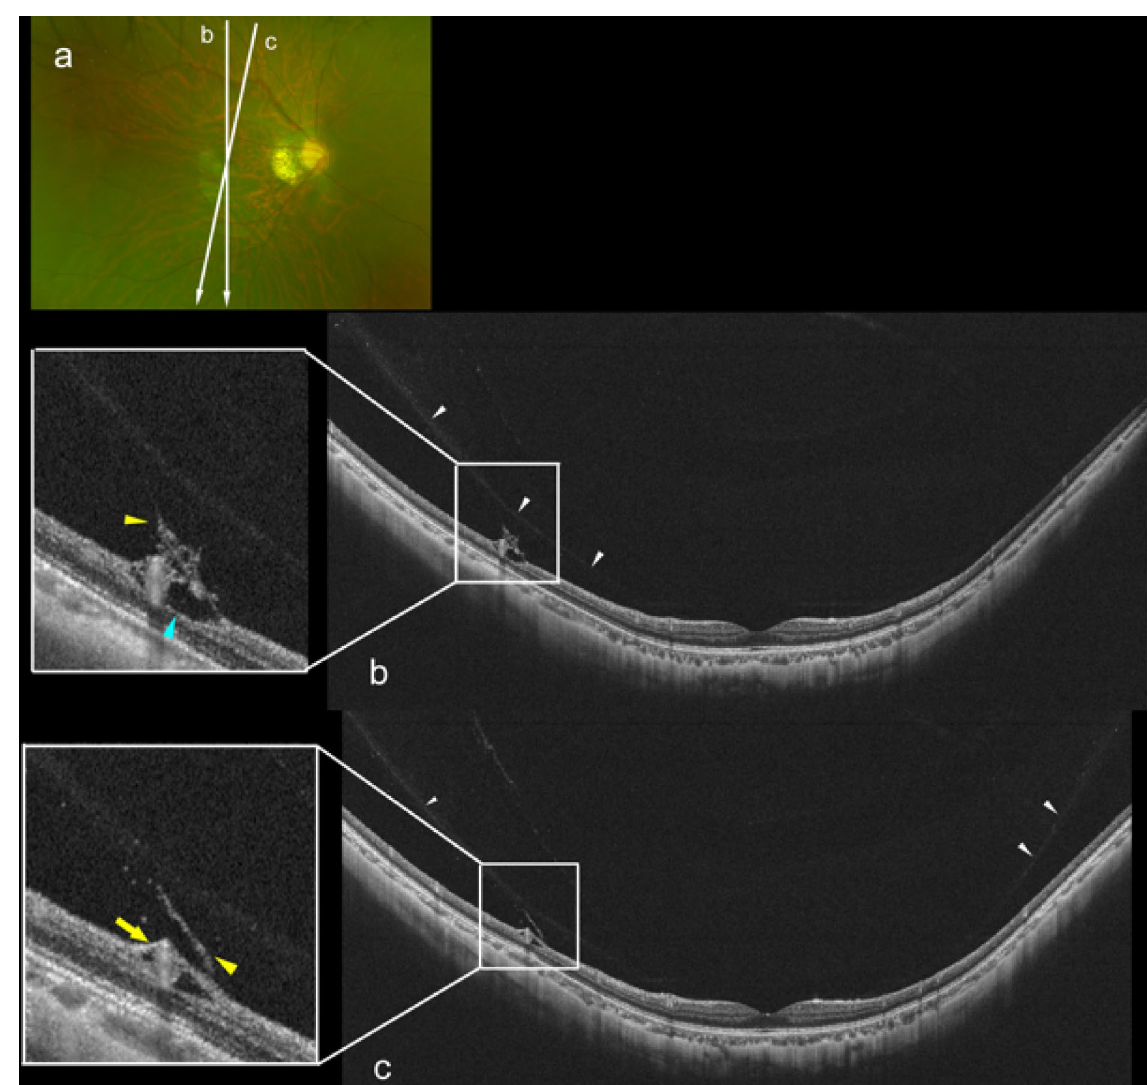
Vertical UWF OCT image showing a paramacular PVD at the area superior to the macula (white arrowhead). Medium reflective bridging tissue can be seen connecting the posterior vitreous surface and retinal vessels (yellow arrowhead). At the site of the adhesion, the retinal vessels are lifted anteriorly. Paravascular retinal cyst are also present (light blue arrowhead). ( c ) Oblique UWF OCT image showing a symmetrical PVD (white arrowheads). Medium reflective bridging tissue connects the posterior vitreous and retinal vessel (yellow arrowhead), and vascular microfolds are present at the site of the adhesion (yellow